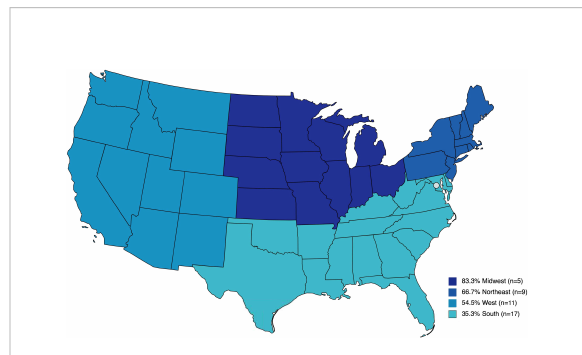
FIGURE 1 Percent of institutions that participated in the survey and offer gonadal tissue cryopreservation by United States census region.